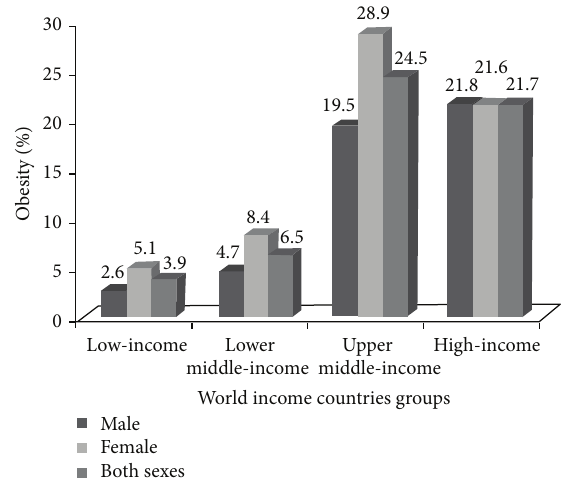
Figure 2: The obesity prevalence among adults aged ≥ 20 years by World Bank income groups in 2008 (%). Source: Statistical data taken from World Health Organisation